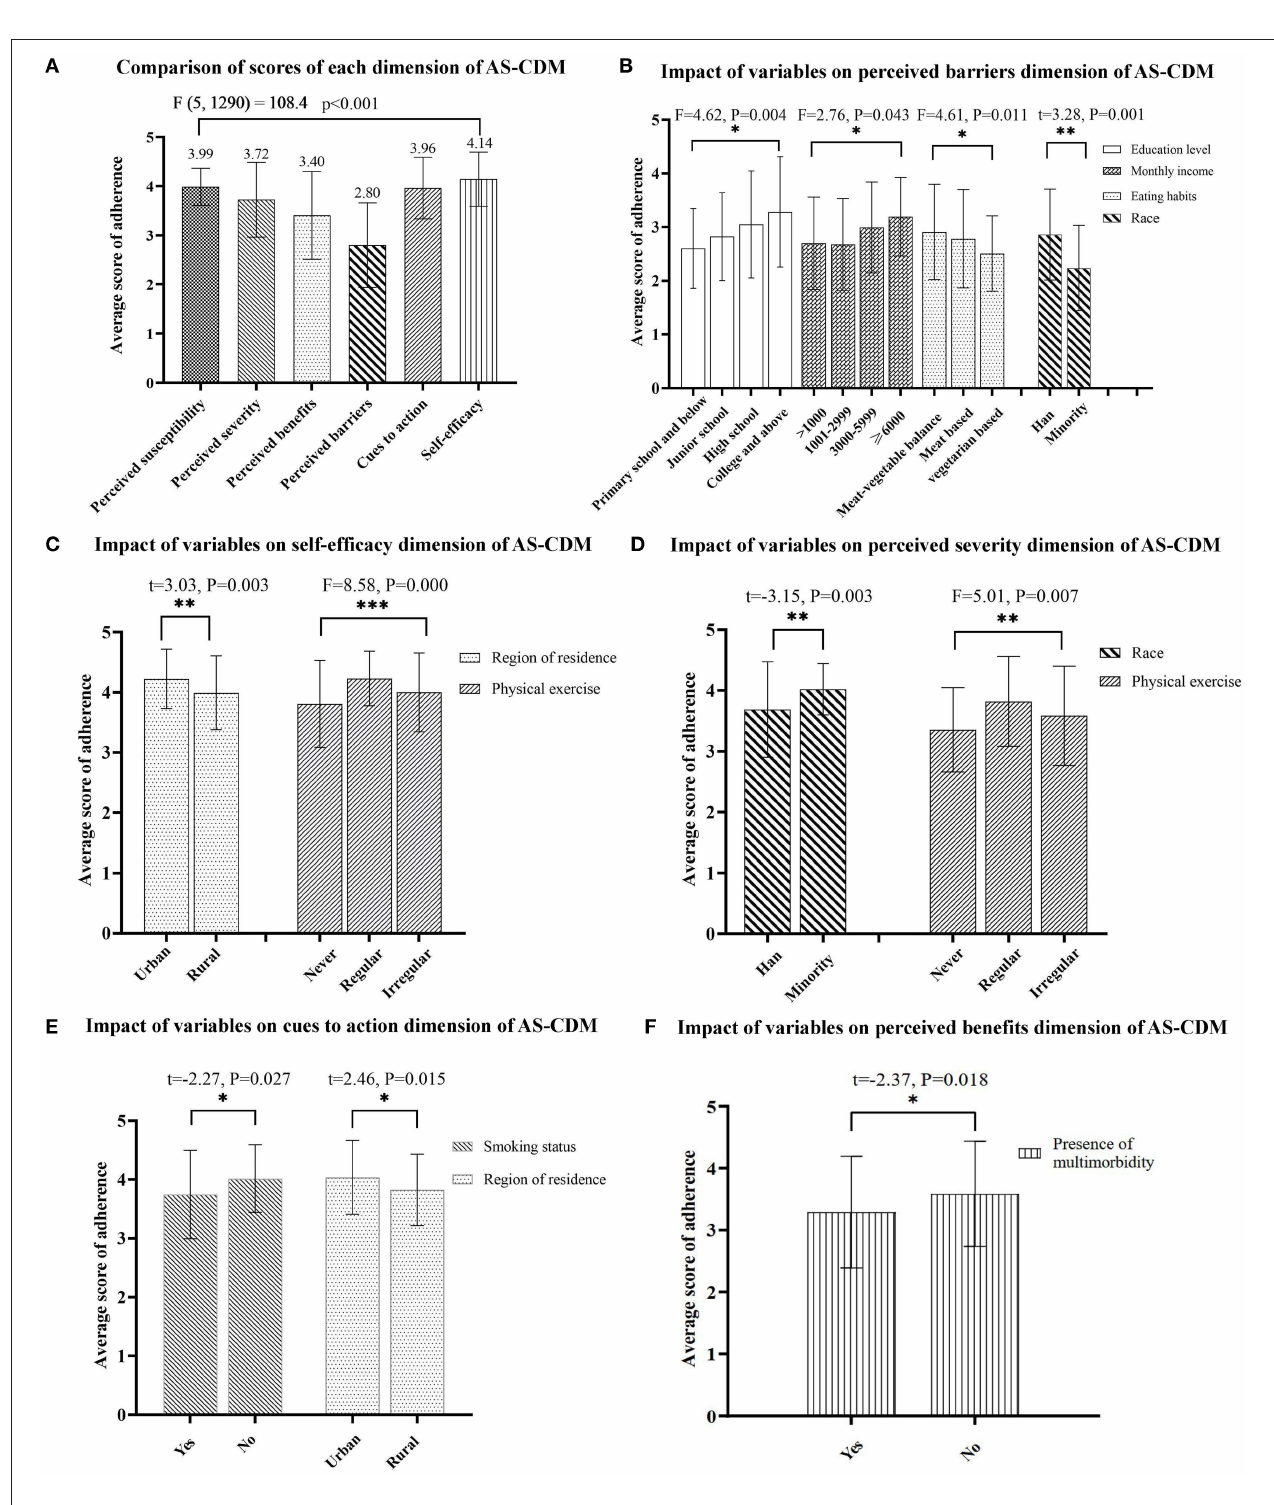
FIGURE 2 | (A–F) Analysis of variables associated with dimensions scores of adherence. * p < 0.05, ** p < 0.01, *** p < 0.001.